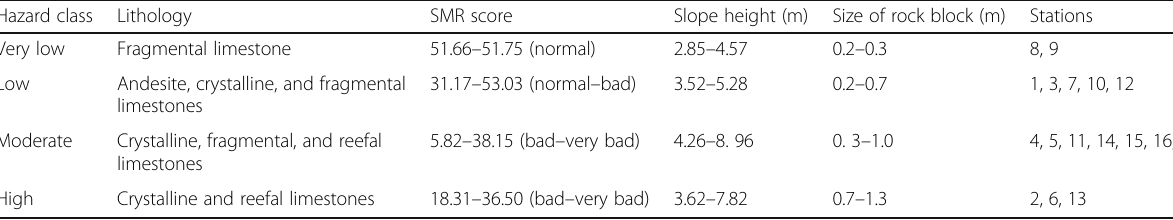
Table 18 The summary of rockfall hazard class and the parameters Hazard class